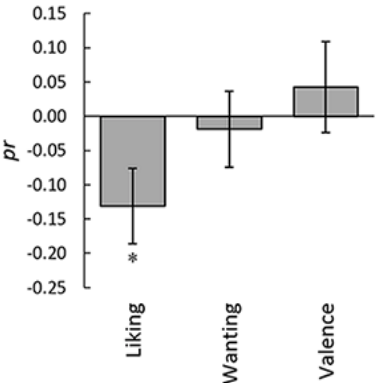
Figure 5. Mean (with standard error) intraindividual partial correlation coefficients between subjective ratings and corrugator supercilii electromyography activity, controlling for the other two ratings. * p < 0.05.